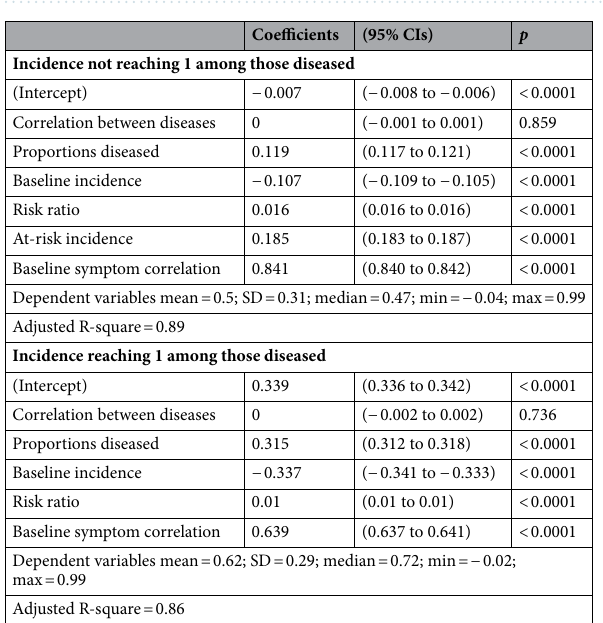
Figure 2. Symptom incidence depending on the baseline incidence, proportions diseased, and risk ratios. RR risk ratios.